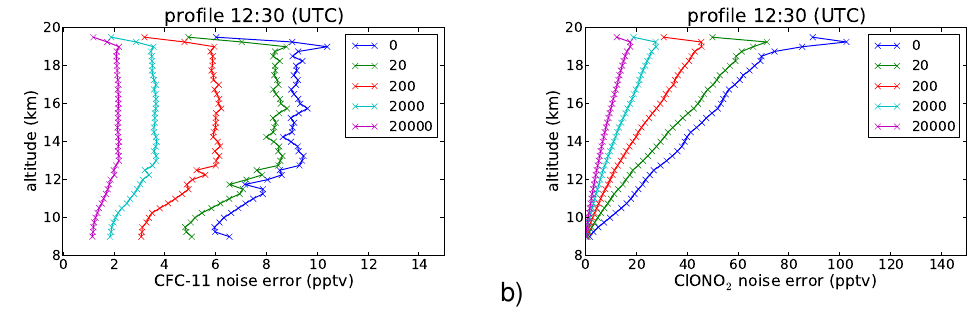
Fig. 7. Error induced by measurement noise for CFC-11 (a) and ClONO 2 (b) , respectively, for one representative profile (12:30UTC) and varying horizontal regularisation strengths. The given number indicates the horizontal regularisation multiplier compared to baseline vertical regularisation strength.